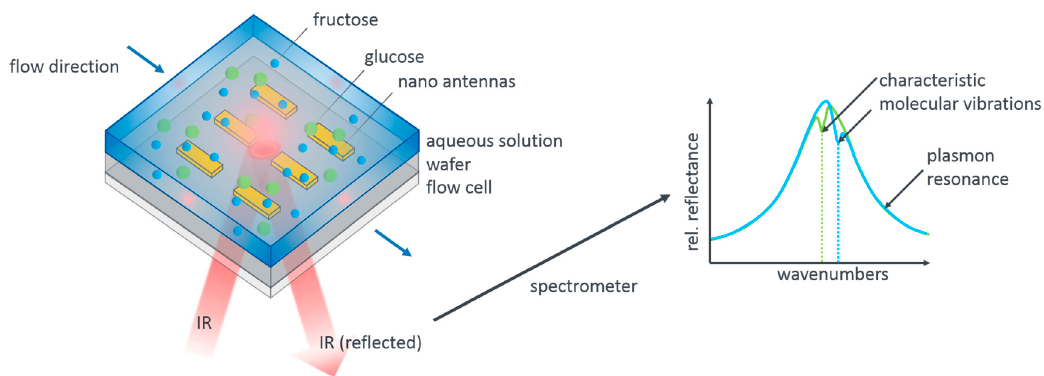
Figure 1. Measurement principle and sensor design. Aqueous pure glucose and fructose solutions as well as mixed solutions are flushed over plasmonic nanoatennas resonant with the characteristic mid-infrared vibrational modes of these monosaccharaides. The tailored flow cell allows to simultaneously acquire reflectance spectra, as sketched on the right hand side. The reflectance peaks of the antennas are modified by the vibrational signatures of the molecular species present in the analyte. From their spectral position the molecular species can be determined, from their modulation depth, in principle, the concentration, given appropriate evaluation and calibration, which is the key result reported here.